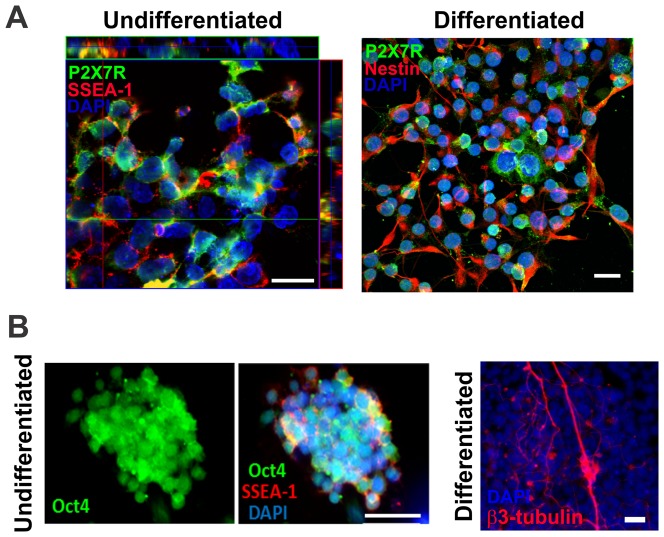
Immunofluorescence studies of P2X7 receptor and differentiation-stage specific proteins in undifferentiated and differentiated ESC.P2X7R expression and co-localization with differentiation-stage specific proteins was determined by confocal microscopy and immunofluorescence assays as described in Materials and Methods. (A). Left panel: Co-localization between SSEA-1 (stage-specific embryonic antigen-1) and P2X7R immunofluorescence in undifferentiated ES cells. Co-localization of the protein is shown by Z-stack analysis. Right panel: Double-immunostaining for nestin (neural stem and precursor marker) and P2X7R expression in cells induced to differentiation for 8 days. (B). Left panel: Immunostaining for Oct-4 (pluripotency marker) in undifferentiated cells. Middle panel: Immunostaining for Oct-4 and SSEA-1 in undifferentiated cells. Right panel: Staining pattern for the neuron-specific marker β-tubulin in neural-differentiated cells. Cell nuclei were visualized by DAPI staining. Scale bar, 50 µm.